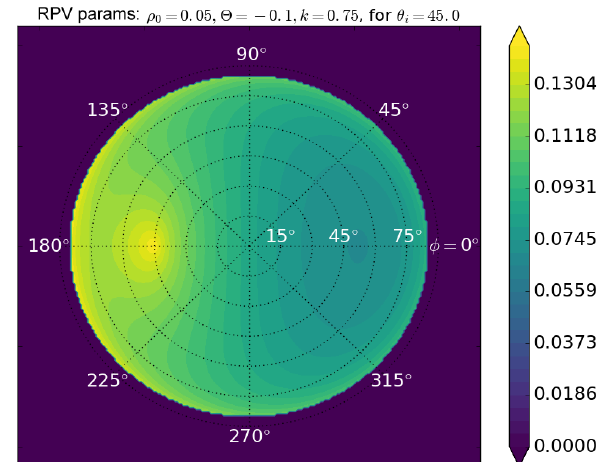
Figure B1. The shape of the RPV kernel for all reflection angles, for a 45 ◦ solar incidence angle. The incident direction is at 180 ◦ . (meaning the solar irradiance is directed inwards from the left